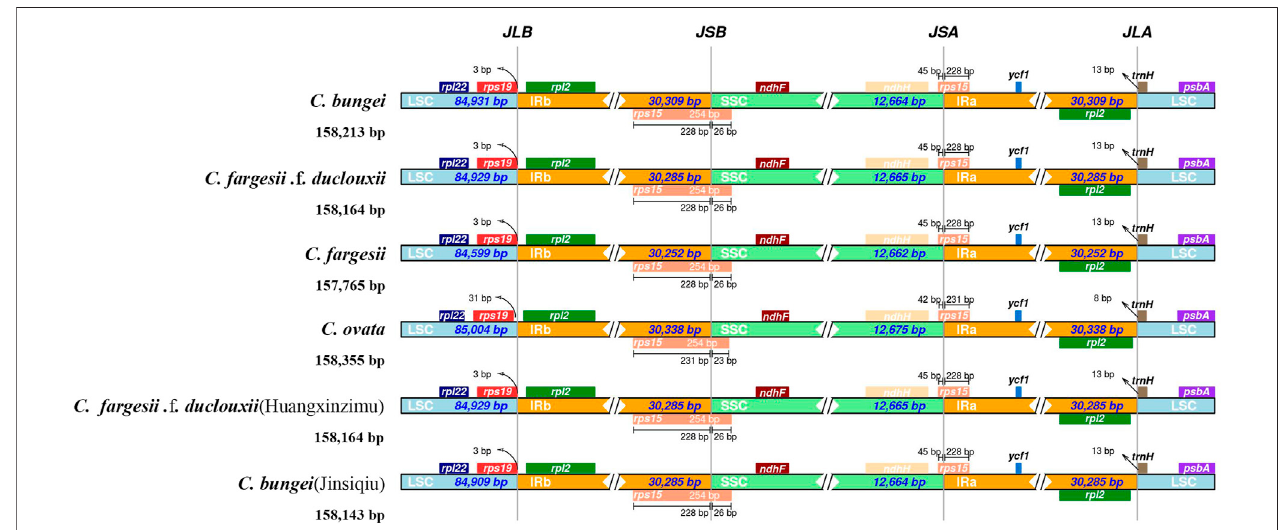
FIGURE 3 | Comparisons of LSC, SSC and IR junctions among six taxa within the genus Catalpa